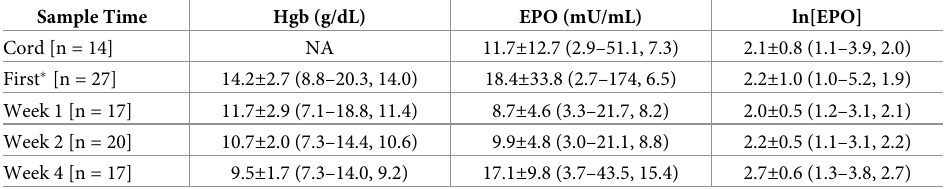
Table 2. Hemoglobin and erythropoietin concentrations over time.